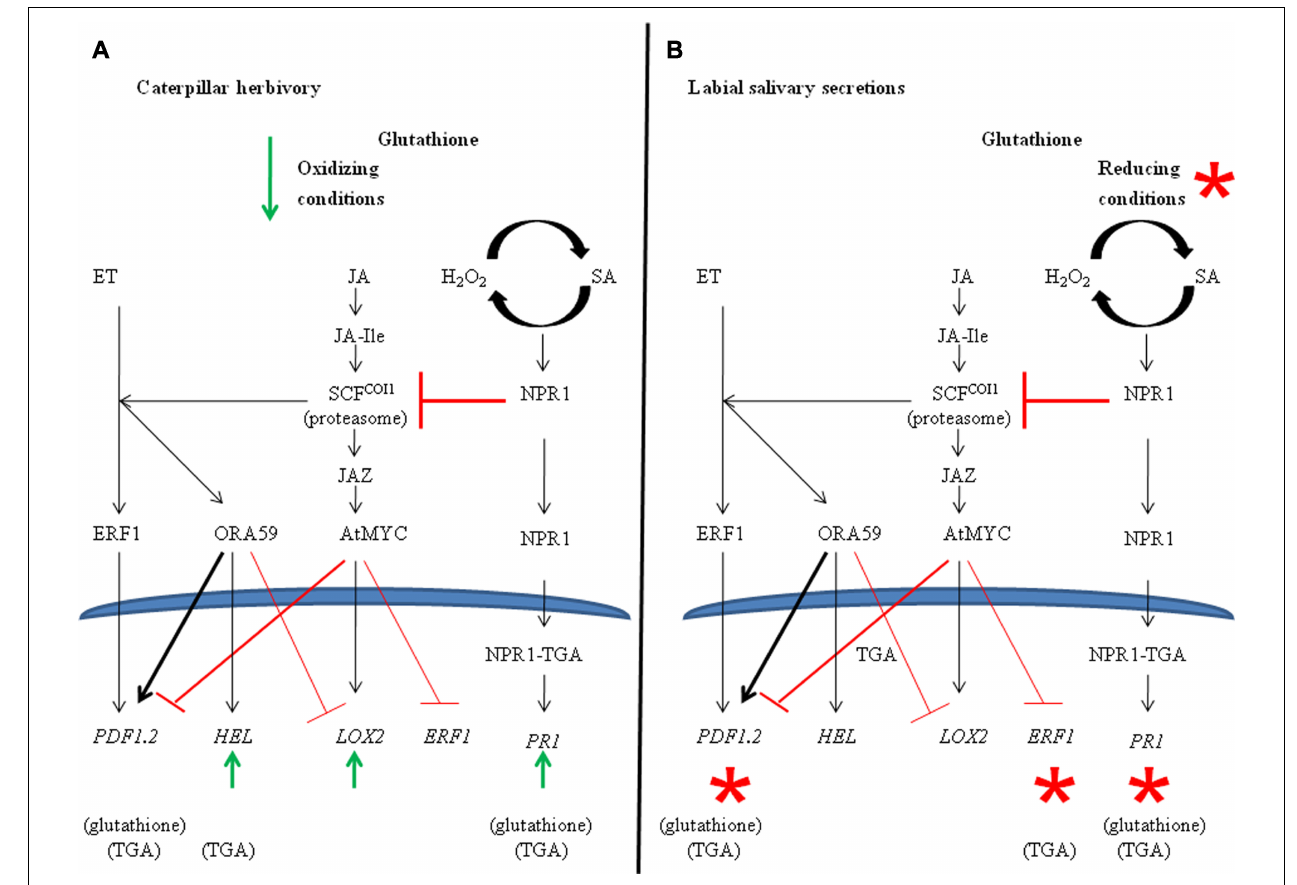
labial saliva (LS) mediated suppression of jasmonate-dependent responses. Illustrates LS-associated changes between plants fed on by caterpillars with intact vs. impaired salivary secretions. Asterisks indicate LS-associated changes. Herbivory by caterpillars with impaired salivary secretions result in cellular oxidative stress (lower total and reduced cellular GSH levels) compared to controls. Induction of the AtPR1 and suppression of AtPDF1.2 and ERF1 are LS-dependent. Involvement of glutathione orTGA transcription factors are indicated in brackets underneath the marker